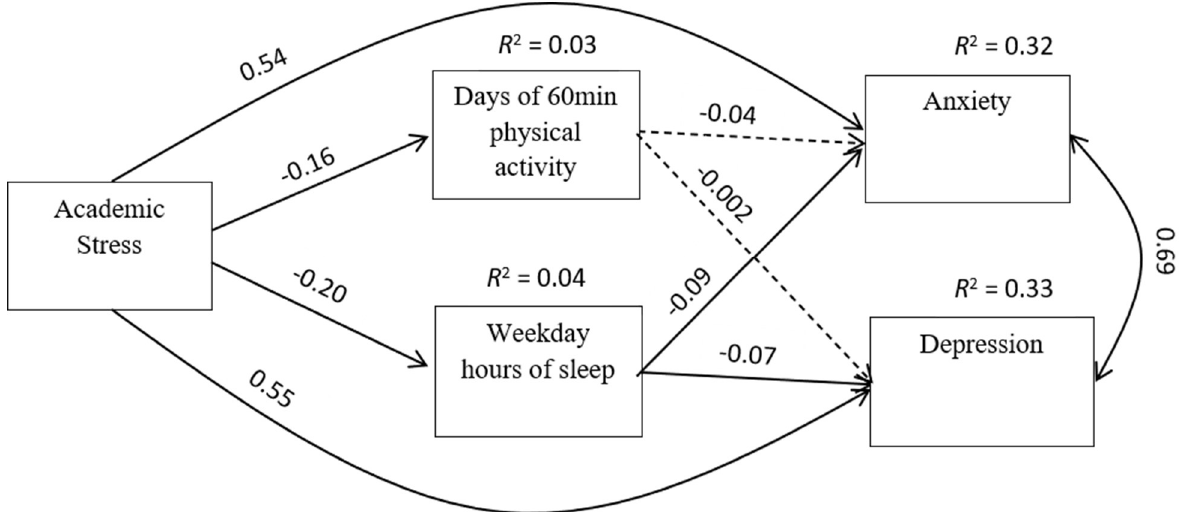
Figure 1. Relations between academic stress, physical activity, sleep, and mental health (dotted lines are not statistically significant, p > 0.05).